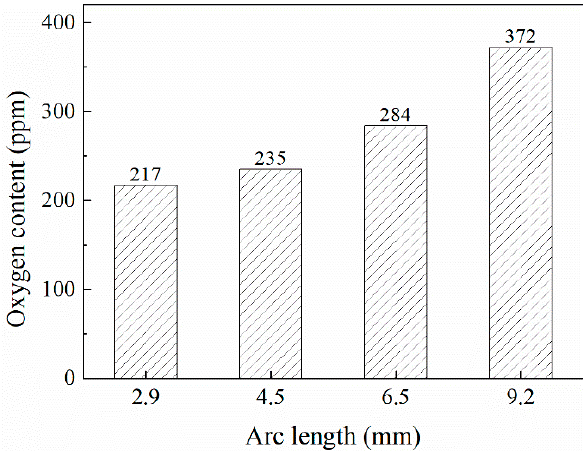
Figure 4. Oxygen content of weld metal under different arc lengths.